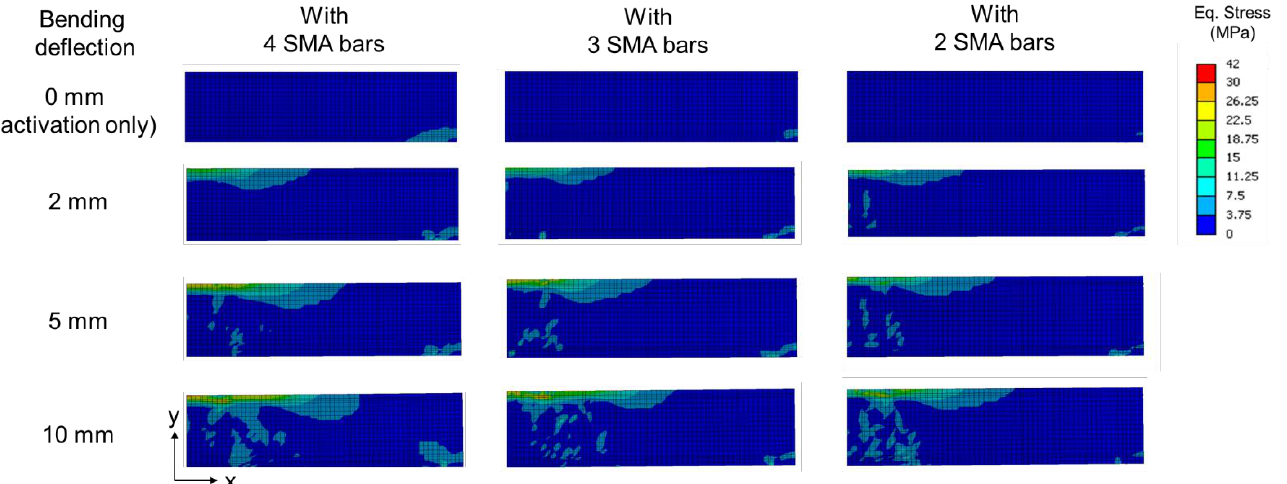
Figure 14. Evolutions of equivalent stress fields of concrete with bending predicted by FE simula- tions of RC beam with activated 4, 3 and 2 Fe-SMA bars. of RC beam with activated 4, 3 and 2 Fe-SMA